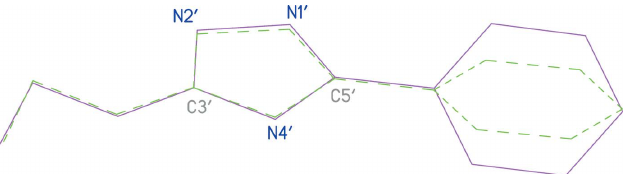
Figure 3 Least-squares fit of all non-hydrogen atoms, except C12, C13, C15 and C16, of inverted molecule A (dashed lines) on molecule B .